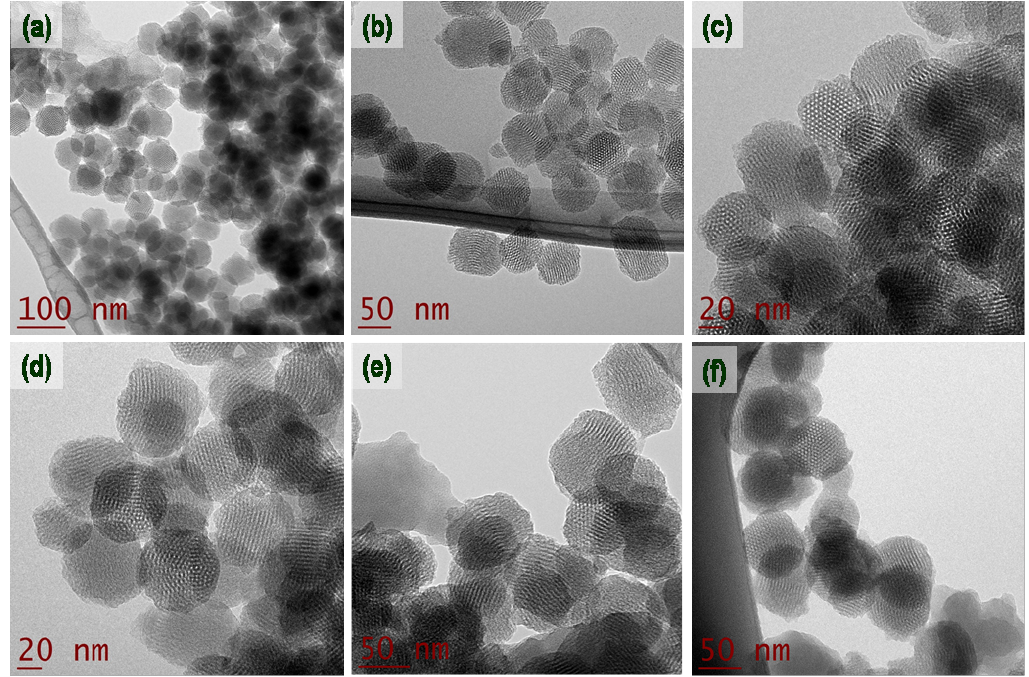
Figure 2: HR-TEM photographs of (a-d) MNPSiO 2 , (e) MNPSiO 2 -FA, and (f) MNPSiO 2 -FA/Cis-Pt